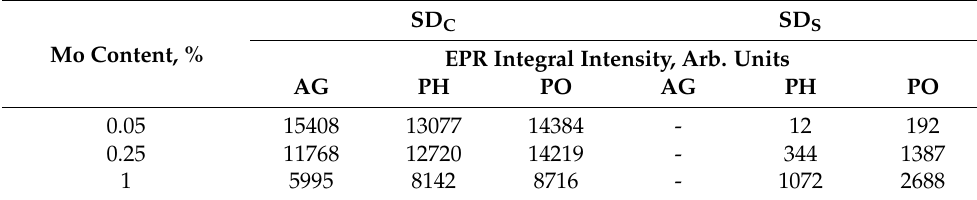
Figure 3. EPR spectra measured at 60 K in the ZnO:Mo(0.05%) ( A ), ZnO:Mo(0.25%) ( B ), ZnO:Mo(1%) ( C ) AG, PH or PO samples. Two dashed vertical line segments indicate the observed specific Mo 5+ signal components in the insets of panels B and C. Table 1. EPR integral intensity of the shallow donor signals.